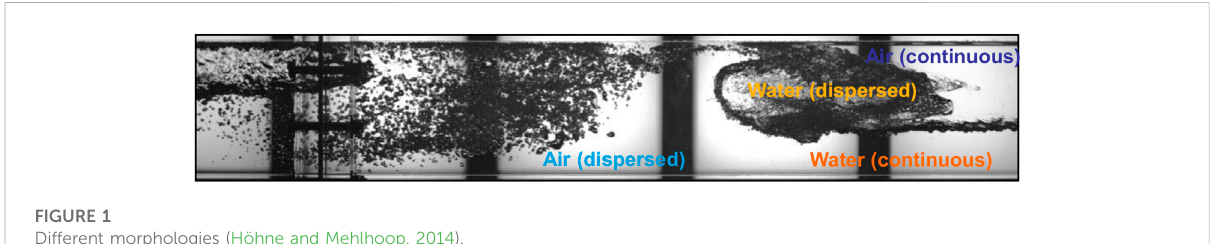
FIGURE 1 Different morphologies (Höhne and Mehlhoop,